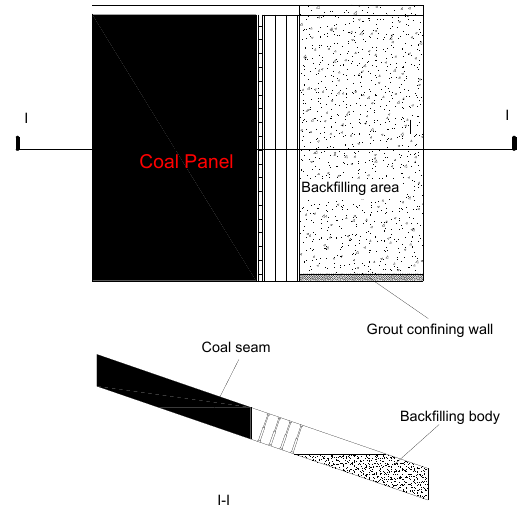
Figure 7. Overview of mining and filling in the coal panel.